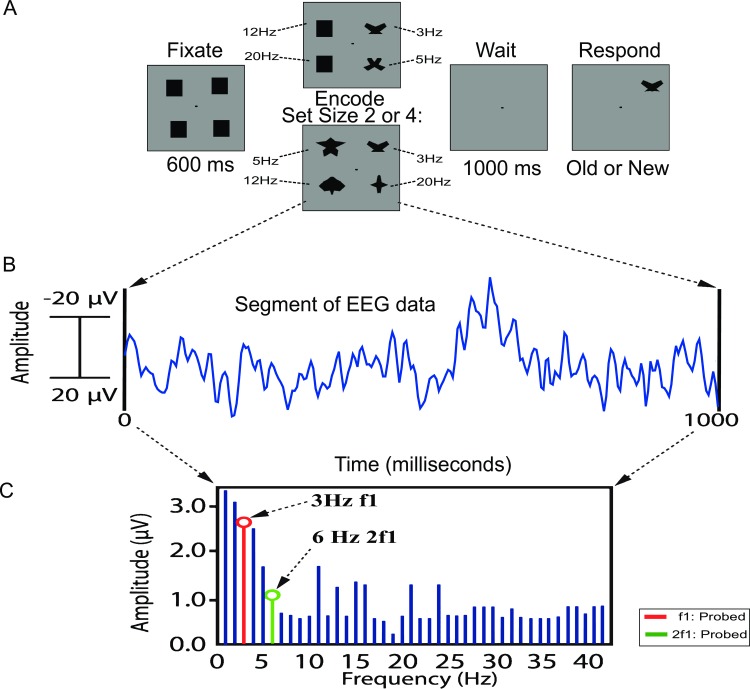
Visual working memory task and data processing sequence.(A) Participants viewed an initial fixation screen (600ms) followed by a memory array (1000ms) in which each item flicked at a distinct frequency (3 Hz, 5 Hz, 12 Hz and 20 Hz). Set size was manipulated to create 2 conditions, set size 2 or set size 4. A delay period (1000ms) followed the stimulus presentation. Finally, a single probed stimulus appeared in one of the four previously presented locations. Participants were instructed to indicate whether the probed stimulus was old (same shape in same location) or new (different shape). Note: black squares were used in the fixation period to control for onset VEP responses that could contaminate the data. (B) Epochs lasting 1000 ms time-locked to the onset of the memory array were extracted from the raw data. (C) In the evoked analysis, once epochs in each condition were averaged together, a Fourier Transform was applied to the data so that the frequency tag amplitudes could be extracted for the fundamental (red) and harmonic (green) frequencies corresponding to probed items in the stimulus array. Conversely, in the induced condition, the Fourier Transform is applied to each trial prior to averaging.